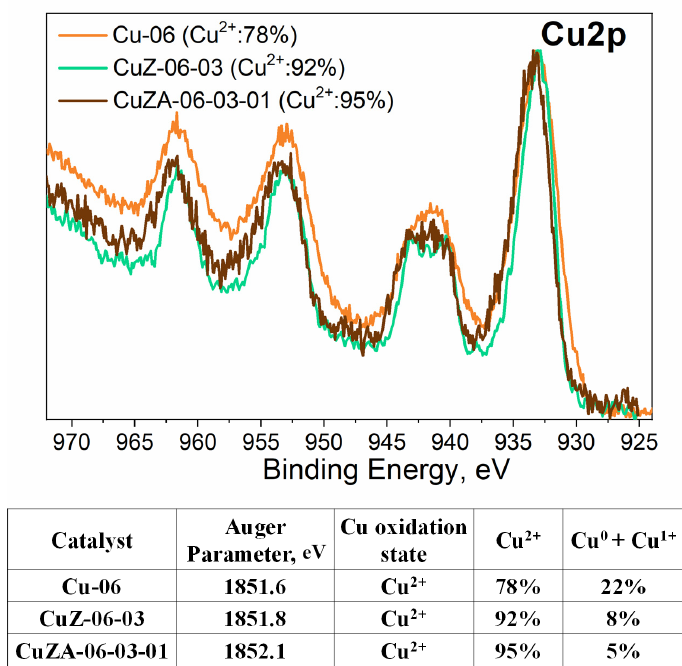
Figure 7. The Cu2p doublet region acquired in high-resolution mode, and the table shows the percentage of oxidation states of copper calculated from Auger parameter values on the surface of the CuZnAl-oxide based catalysts.